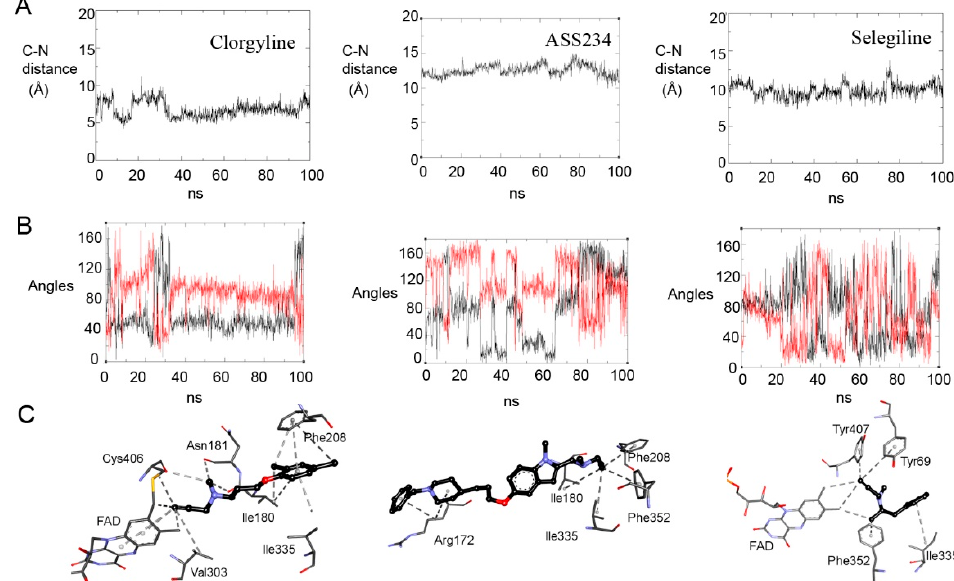
Figure 8. Interactions of propargylamine ligands with oxidized MAO-A. Left : clorgyline; Middle : ASS234; Right : selegiline. ( A ) Poses: clorgyline (at 67 ns of trajectory); ASS234 (at 75 ns); selegiline from its productive pose (at 100 ns). ( B ) Atom plot distances from ligand C α to N5-FAD calculated over 100 ns of simulation. The selegiline trajectory (right) started from the productive pose in which the propargyl group pointed towards the FAD. ( C ) Angle N5…H-C.